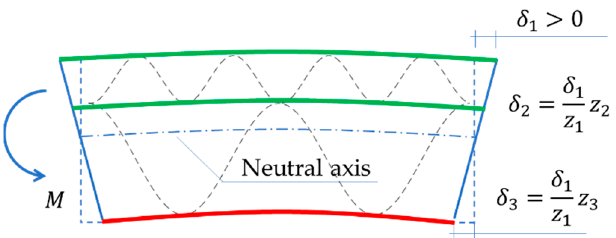
Figure 7. Corrugated board bending–compressing the layers of lower fluting.